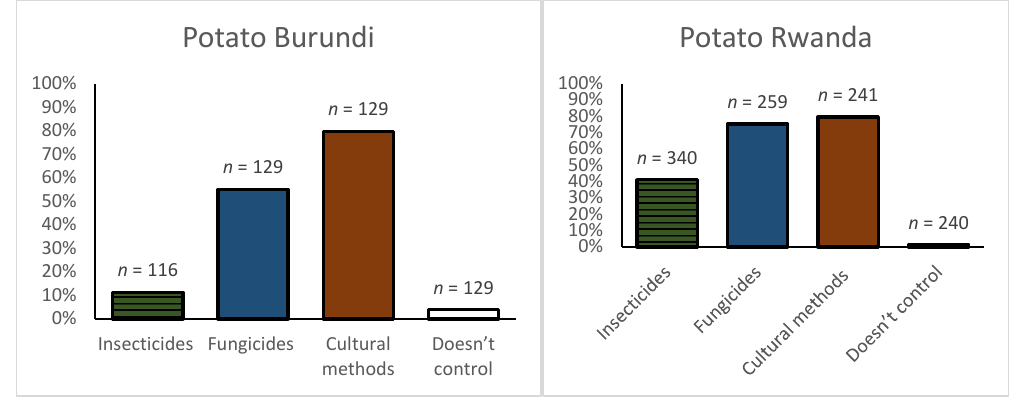
Figure 2 . Pest and disease management practices used in potato in Rwanda and Burundi. Multiple responses were possible. n = number of responses.